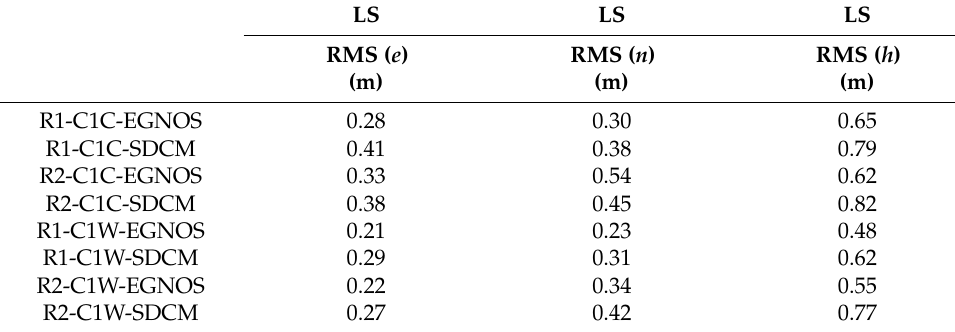
Figure 8. Real errors of horizontal and vertical coordinates of SBAS positioning based on C1W code, for the receiver Rec2 with EGNOS or SDCM corrections (Step II, see Figure 1). Table 1. Average RMS errors for EGNOS and SDCM positioning, and C1C and C1W codes.